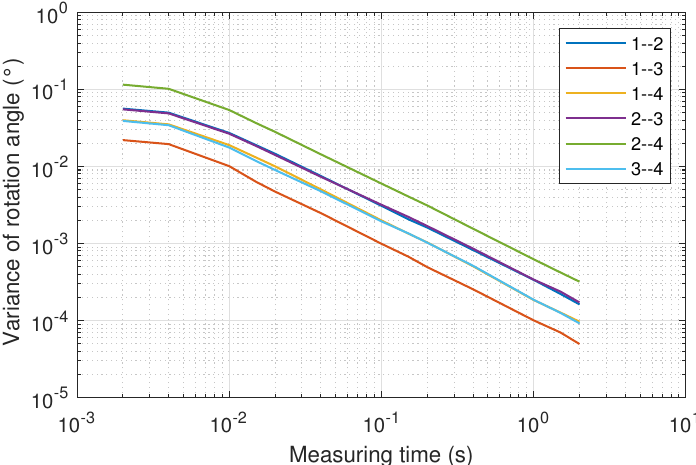
Figure 12. Mean value of the variance of the rotation angles as a function of the measurement time for each combination of the emitters pairs.